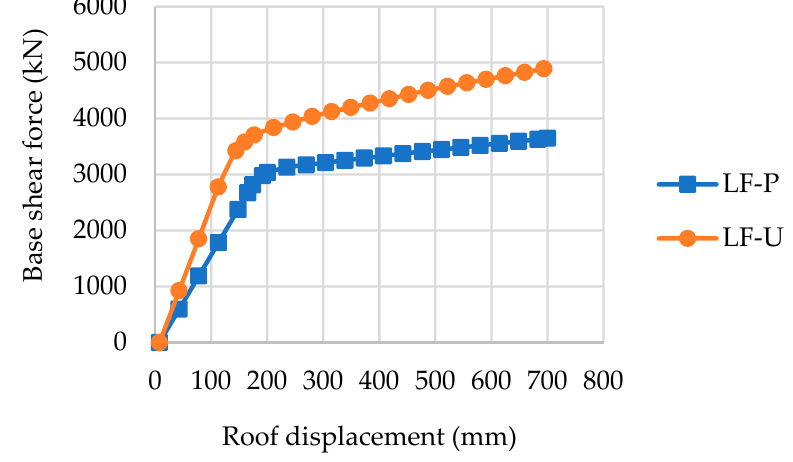
Figure 7. Base shear response.